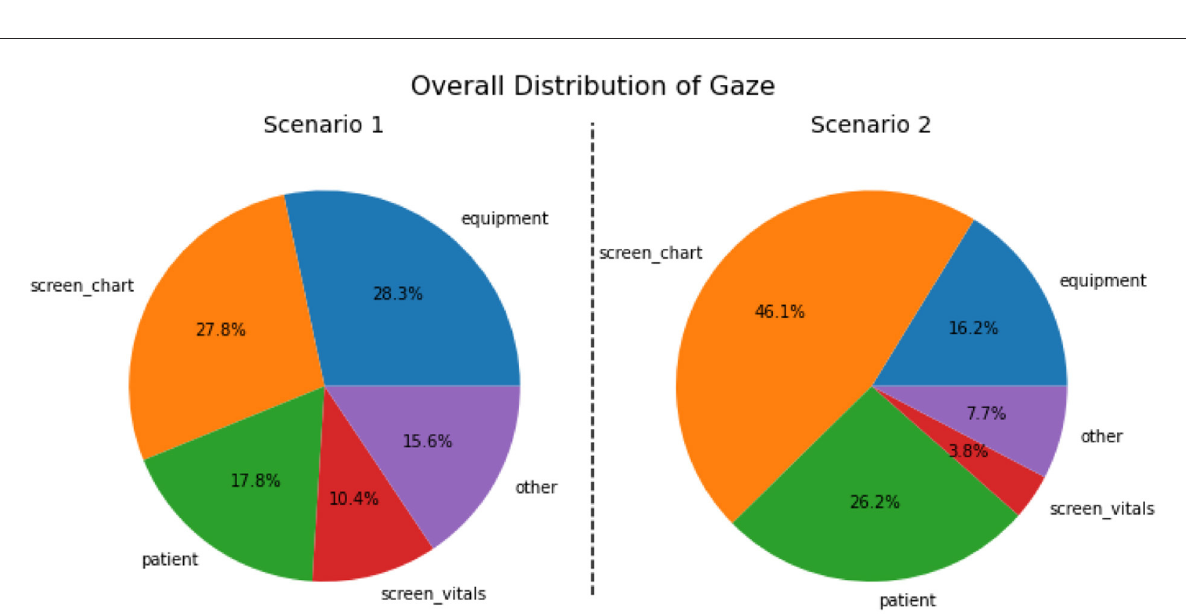
FIGURE13 Marginal distribution of nurse gaze across five major object categories for each scenario.